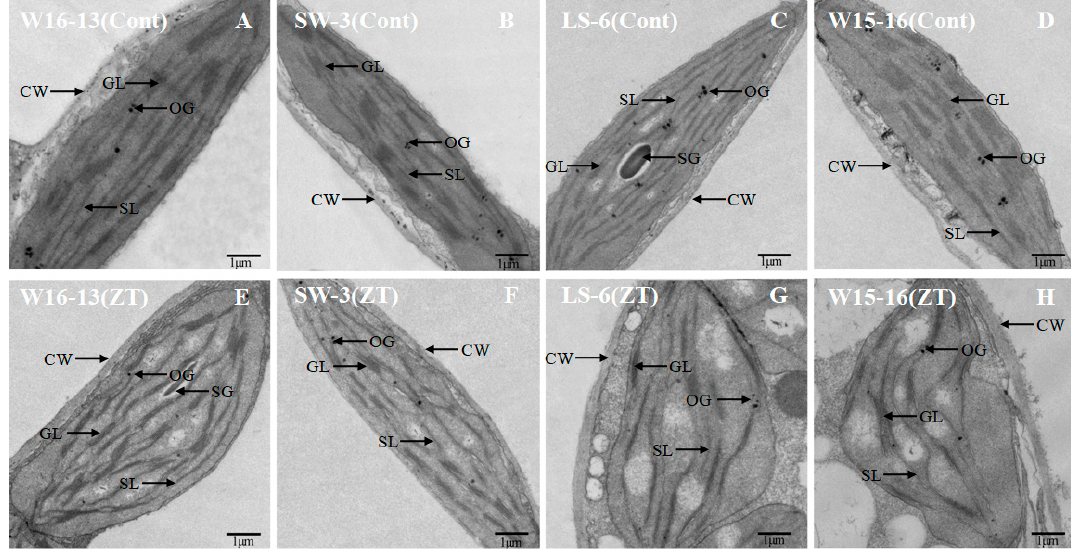
Figure13. Transmission electron micrographs showing changes in ultrastructure of chloroplast of wucai seedlings under cold stress. Cont [25/18 °C (d/n)] ( A – D ), ZT [0/ − 6 °C (d/n)] stress treatment ( E – H ). SG: starch globule, GL: grana lamellae, SL: stroma lamellae, CW: cell wall, OG: osmiophilic granules.